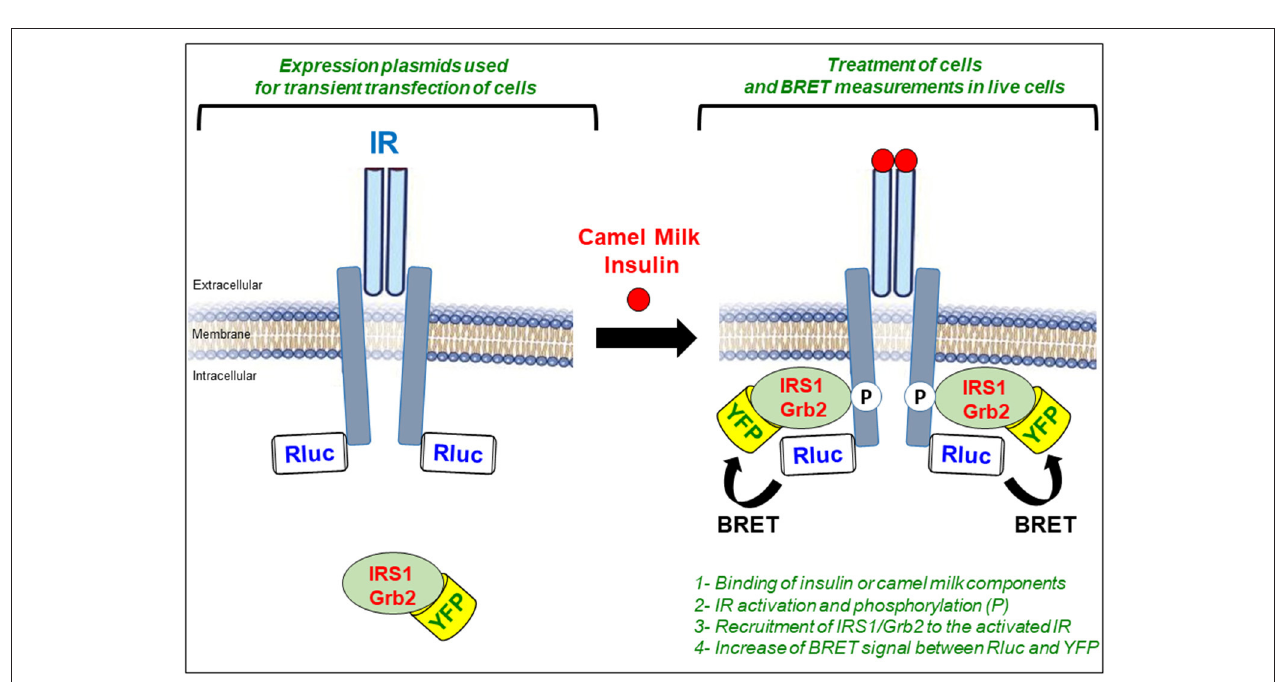
FIGURE 5 | Representative figure highlighting the principle of BRET assay to assess IR activation. BRET is a proximity-based assay carried out in live HEK293 cells transiently co-transfected with plasmids encoding for Rluc-tagged IR (BRET donor) and YFP-tagged IRS1/Grb2 (BRET acceptor). Cells are then treated either with insulin as a positive control or with CM fractions in time and dose-dependent manner and BRET signals are measured in live cells. Activation of IR results in the translocation of IRS1/GRb2 to IR reducing their physical proximity. This is translated in the increase of the BRET efficiency between the BRET donor (Rluc) and the BRET acceptor (YFP)